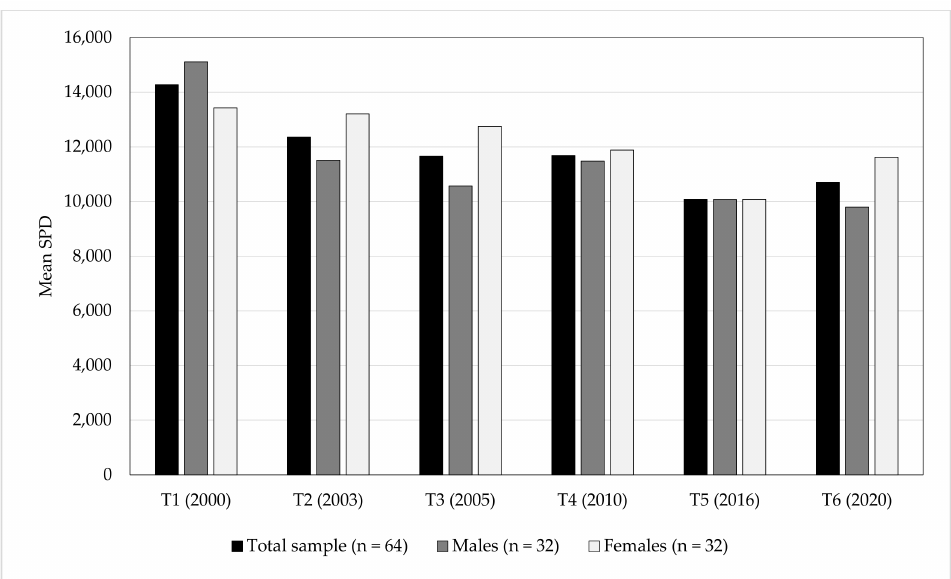
Figure 1. Mean SPD at T1–T6 among the total sample (black bars), and stratified by males (dark grey bars) and females (light grey bars),